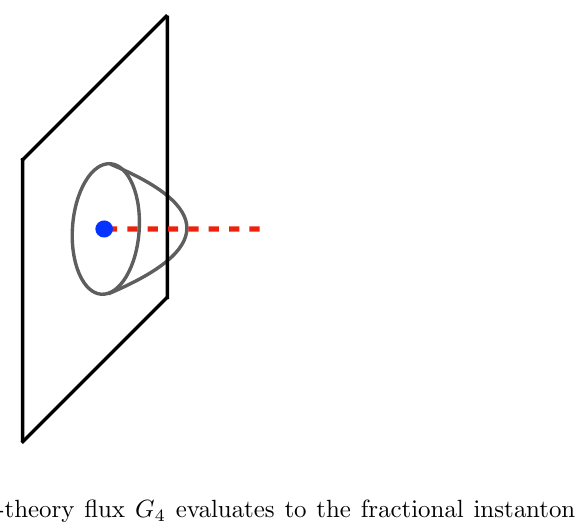
Figure 4 . 4-chain on which the M-theory (cid:13)ux G 4 evaluates to the fractional instanton number, i.e. the number of